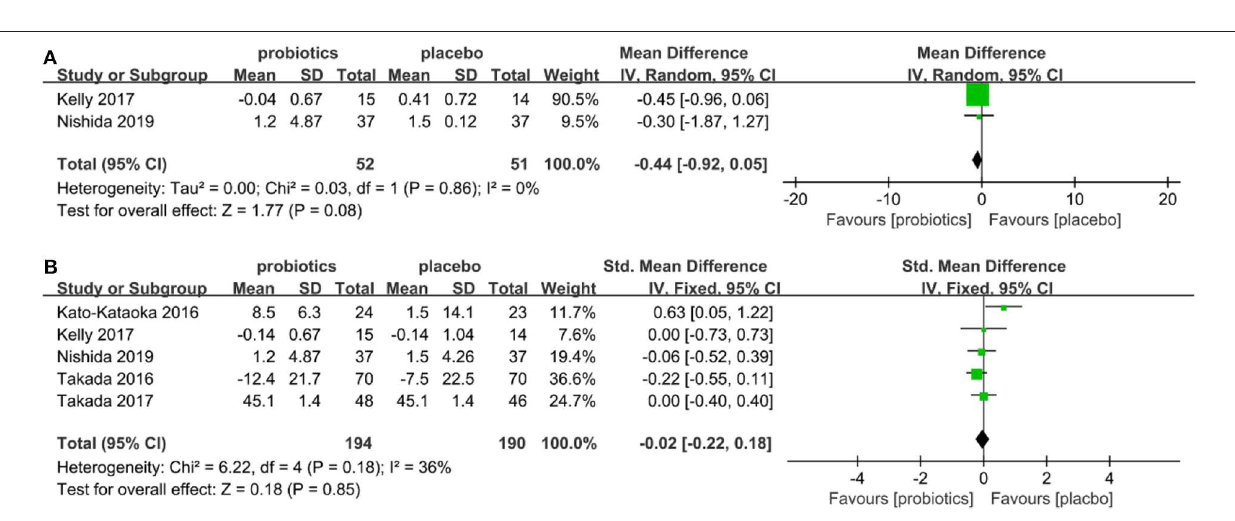
the probiotics group and the placebo group (SMD =